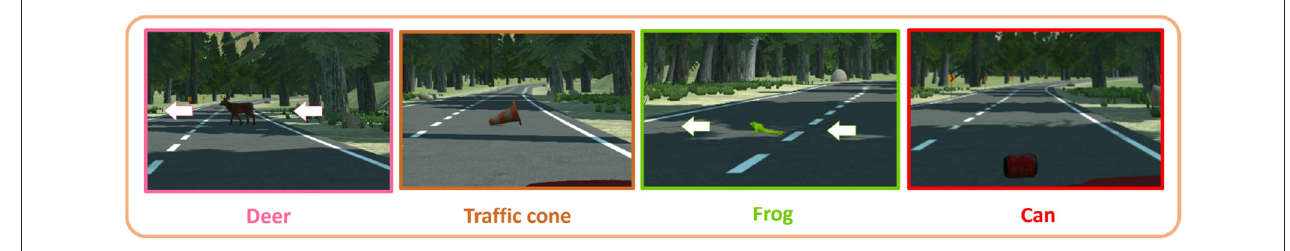
FIGURE 1 | Takeover situations.